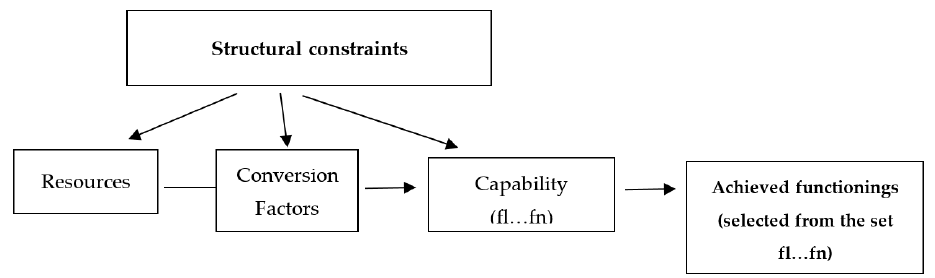
Figure 1. Diagram of the “capabilities approach” (CA) core concepts. Source: adapted from (Robeyns 2017, p. 83).